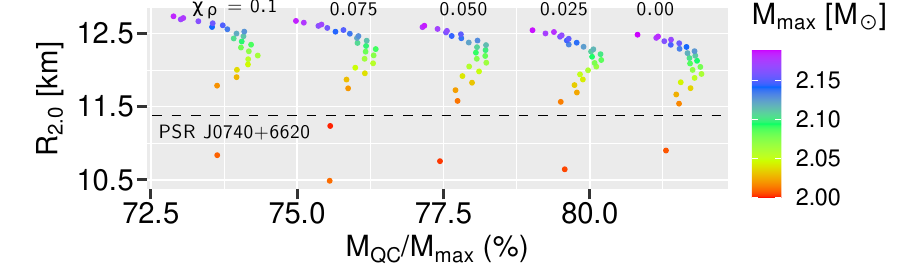
Figure 5. Radius of 2 . 0 M (cid:3) hybrid stars as a function of the quark core mass fraction of the M max . All models presented here predict a quark core in a 1 . 4 M (cid:3)